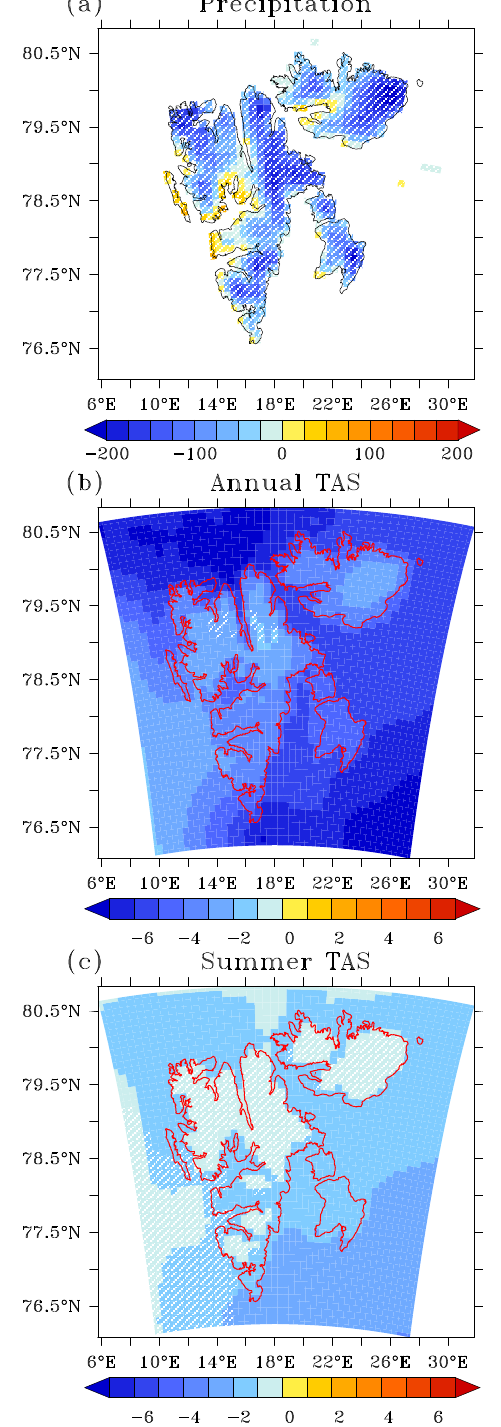
Figure 13. (a) Annual precipitation difference (mmyr − 1 ) between MAR MIROC5 and MAR ERA averaged over 1980–2005. (b) Same as (a) but for the annual near-surface temperature ( ◦ C). (c) Same as (b) but for summer (JJA). The non-hatched areas correspond to the areas where the difference is significant (i.e. higher than twice the interannual variability of MAR ERA ).